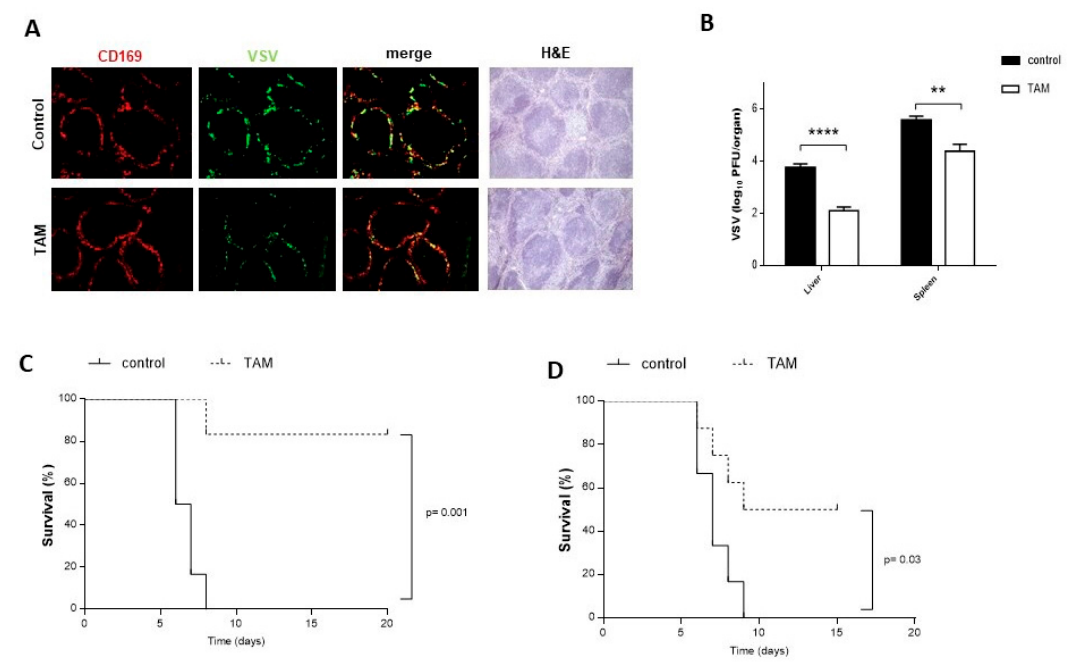
Figure 2. Pretreatment with TAM inhibits early VSV replication in vivo, improving survival after VSV infection. ( A ) Immunofluorescence and H&E staining of snap-frozen spleen tissues obtained from TAM pretreated and control mice 8 h after VSV infection. Spleen sections were stained for CD169 (red) and VSV glycoprotein (green). Scale bar = 100 µ m; one representative out of 6 is shown. Fluorescent and light microscopy images were captured at 10x magnification using Keyence BZ-9000E microscope. ( B ) Virus titers were determined in liver and spleen tissues at 8 h post infection in TAM pretreated and control mice ( n = 6). ( C ) C57BL / 6 mice were pretreated intraperitoneally with 4 mg TAM at day -3 and day -1. Corn oil served as control. Survival was monitored in mice intravenously infected with 2 × 10 8 PFU VSV at day 0 over the indicated period ( n = 6). ( D ) Survival was monitored in C57BL / 6 mice initially intravenously infected with 2 × 10 8 PFU VSV at day 0 over the indicated period. TAM treatment (100 µ L / 4mg per mouse i.p.) was administrated twice on day 2 and 3 post VSV infection ( n = 6 or 8). The error bars show SEM. ** p = 0.01; **** p < 0.001.